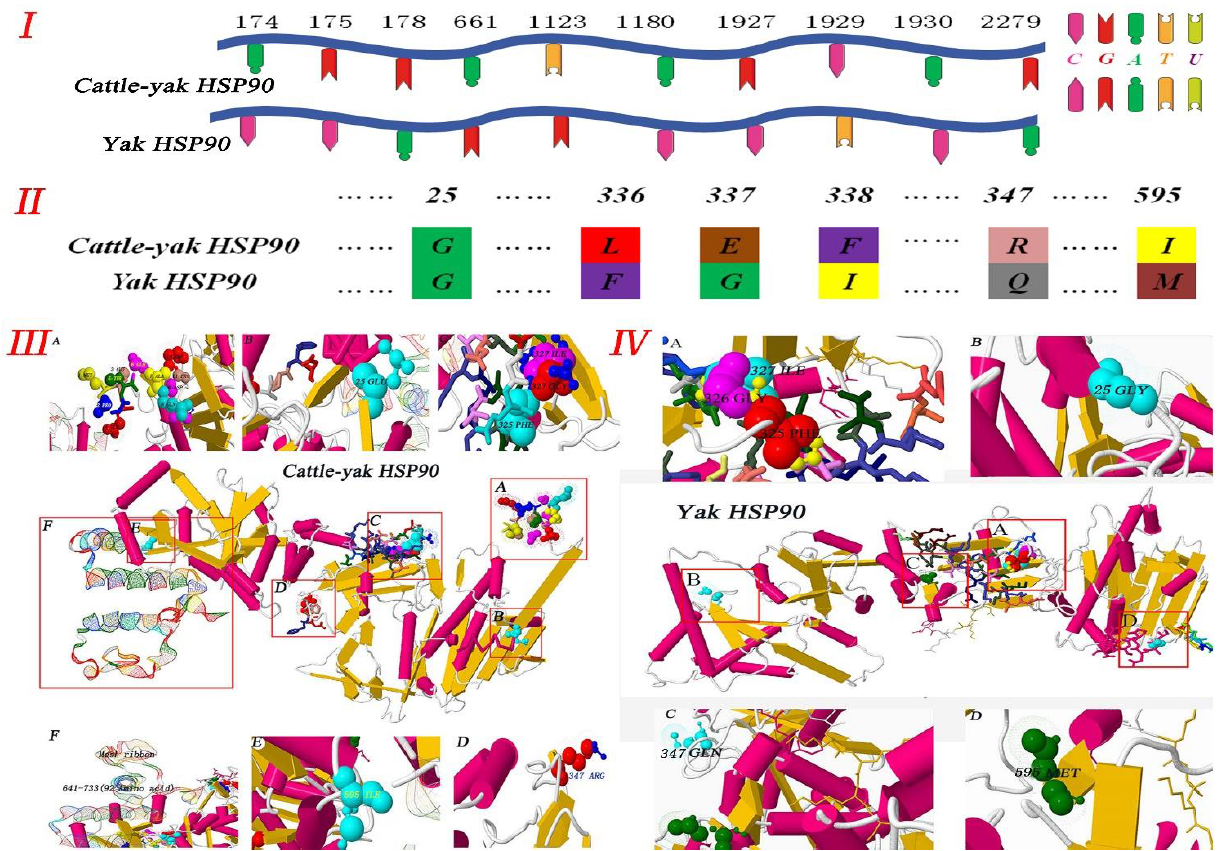
Figure 3. Analysis of Hsp90 protein structure in cattle – yak and yak. ( I ) and ( II ) Hsp90 nucleotide and amino acid sequence analysis showing the sites and types of mutations in cattle – yak and yak.